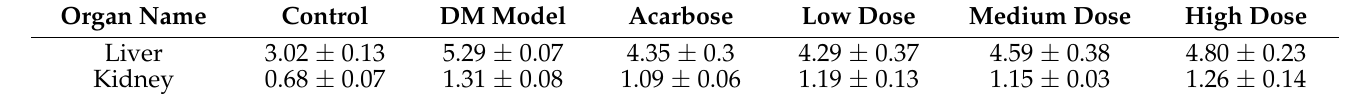
Table 2. Summary sheet of organ coefficient of diabetic rats treated by DC-5 and acarbose for 30 days (Mean ±